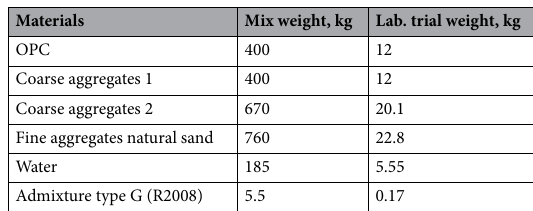
Table 7. Concrete mix design used in this